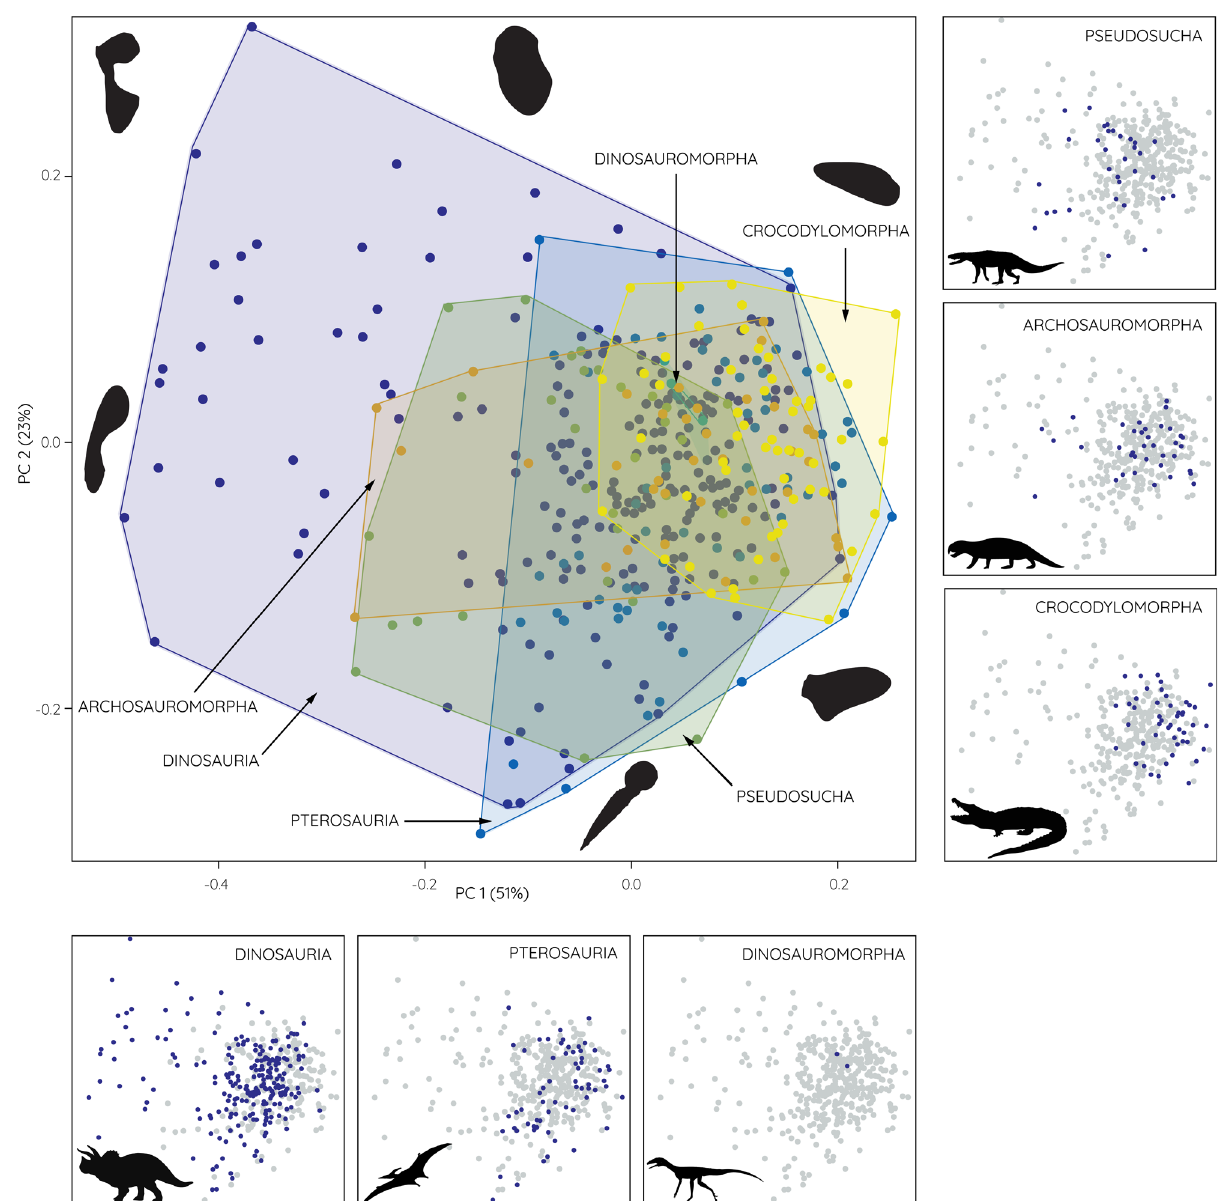
Fig. 1 Orbit shape morphospace occupation of all archosauromorph taxa ( n = 410) and in individual groups. Silhouettes in the main PCA plot represent extreme orbit